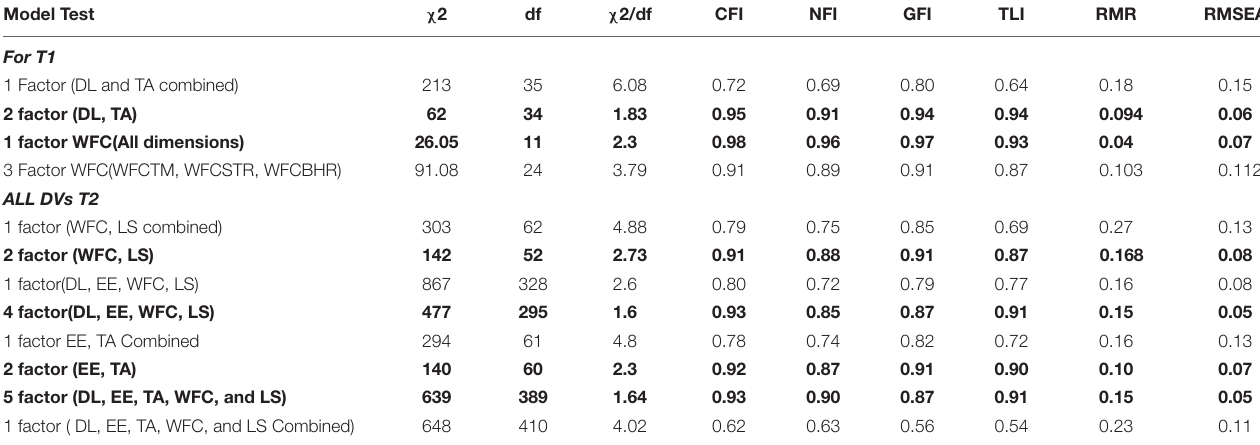
TABLE 2 | Model Fit Indices for CFAs. Model Test